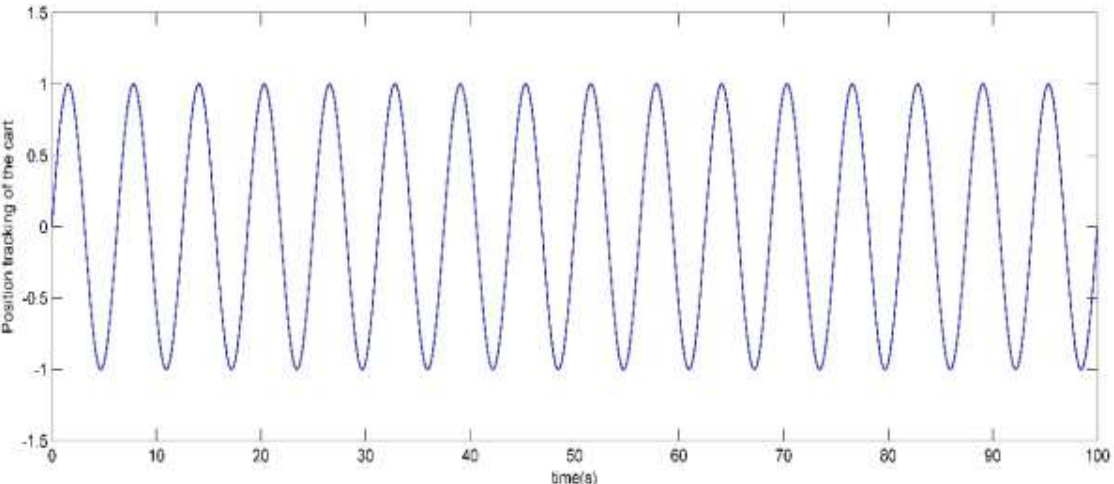
Figure 7. The position tracking vs. time for the cart (dashed blue line is the reference signal, the solid blue line is the output signal and the dashed red line is for the AFHSMC).